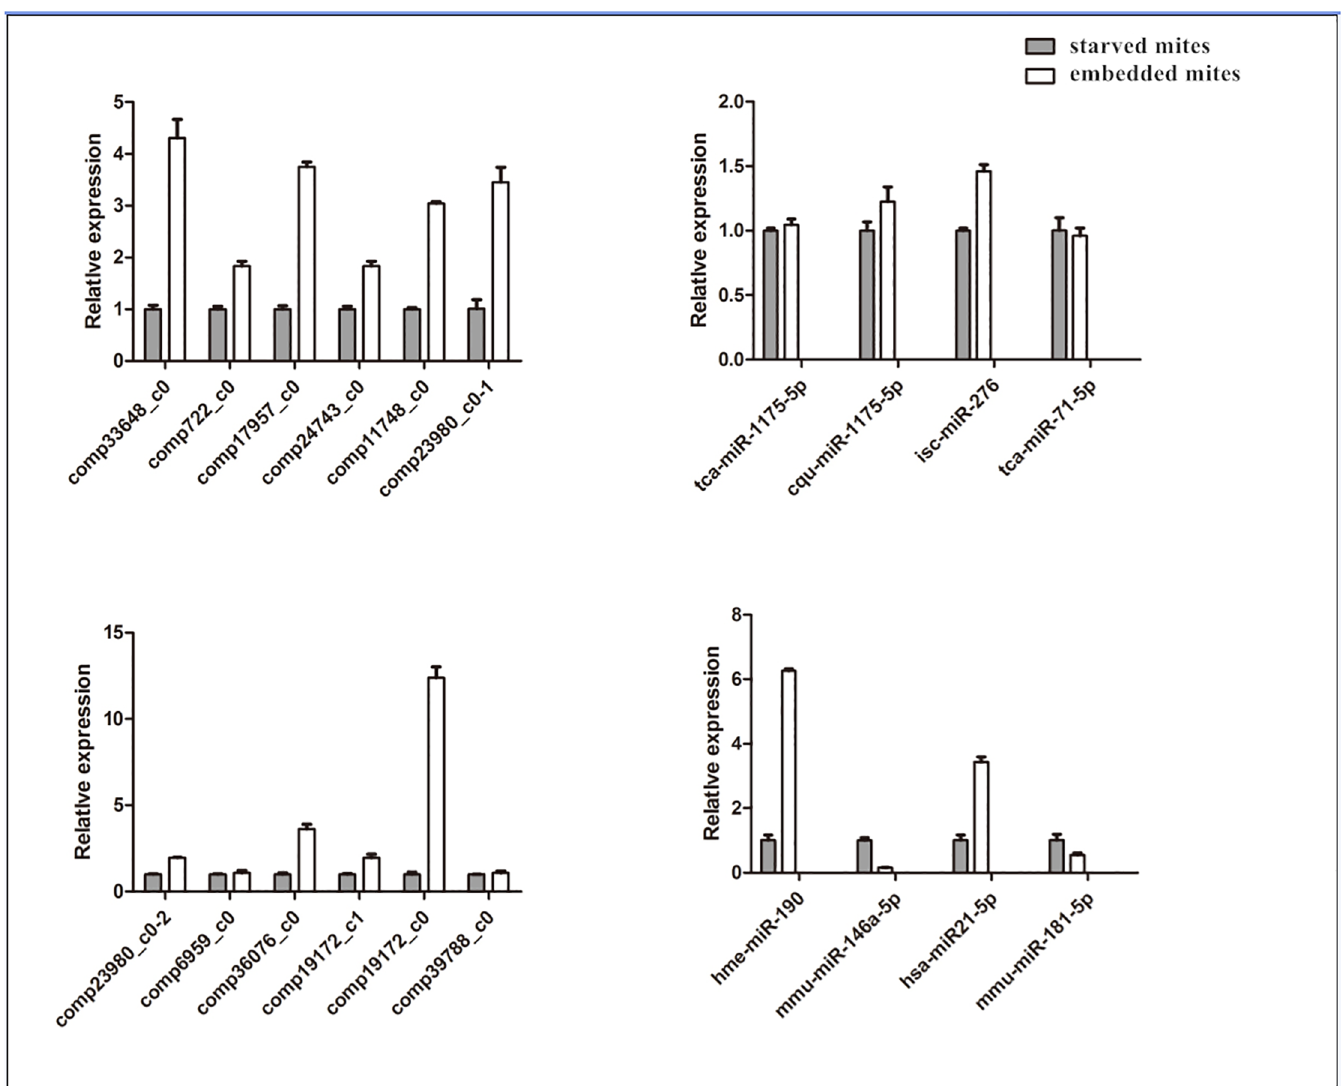
Fig 2. RT-PCR validation of the differentially expressedunigenes and microRNAsfrom Illumina sequencing. The relativeexpressionlevels of toll like receptor signalingpathwayrelated unigenesand immune signaling pathways related microRNAs were determined by RT-PCR using cDNA as template.